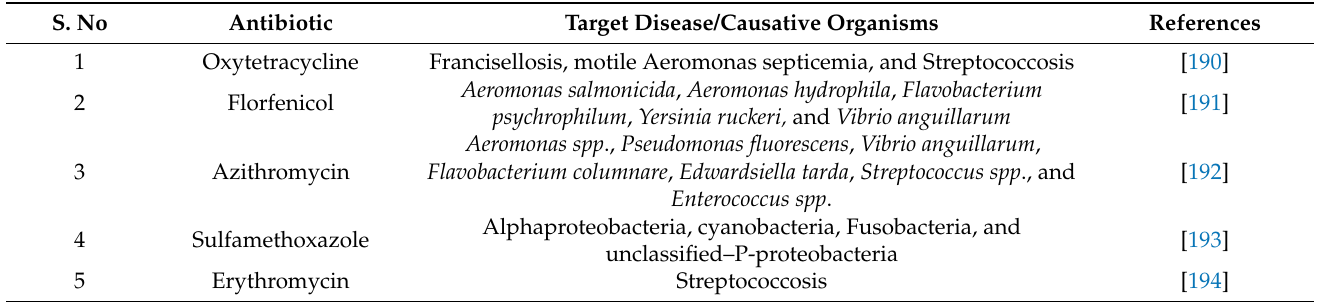
Table 3. Usage of antibiotics in tilapia culture.